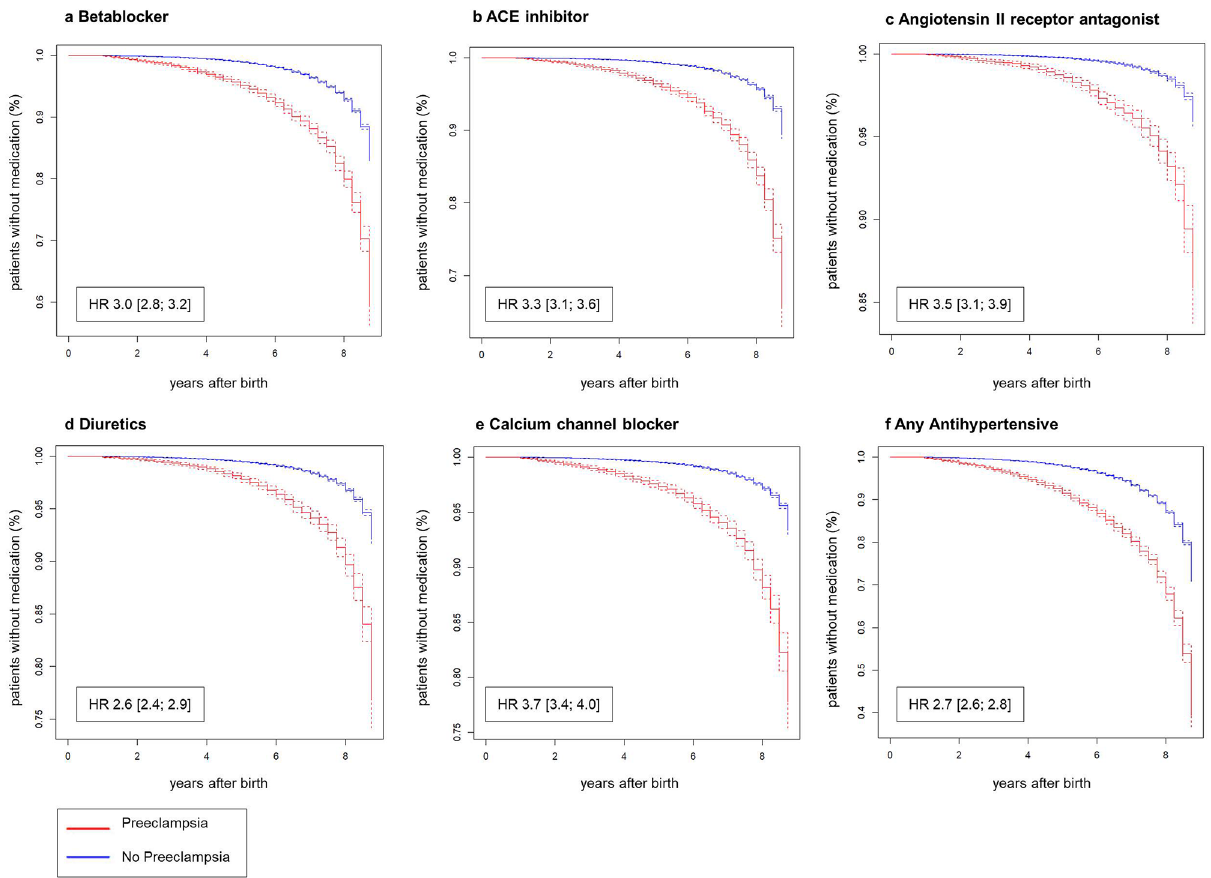
Figure 4. Cumulative hazard plots on the risk to take antihypertensive medication. Cumulative percentage of patients with (red) and without PE (blue) after delivery without betablockers ( a ), ACE inhibitors ( b ), angiotensin II receptor antagonists ( c ), diuretics ( d ), calcium channel blockers ( e ), and any antihypertensive medication ( f ). Hazard Ratios (HRs) and 95% CI were analyzed with the use of a Cox regression model adjusted for maternal age, diabetes, and obesity. Women with diagnosis of prior hypertension to were excluded. P values not shown, as for each p <